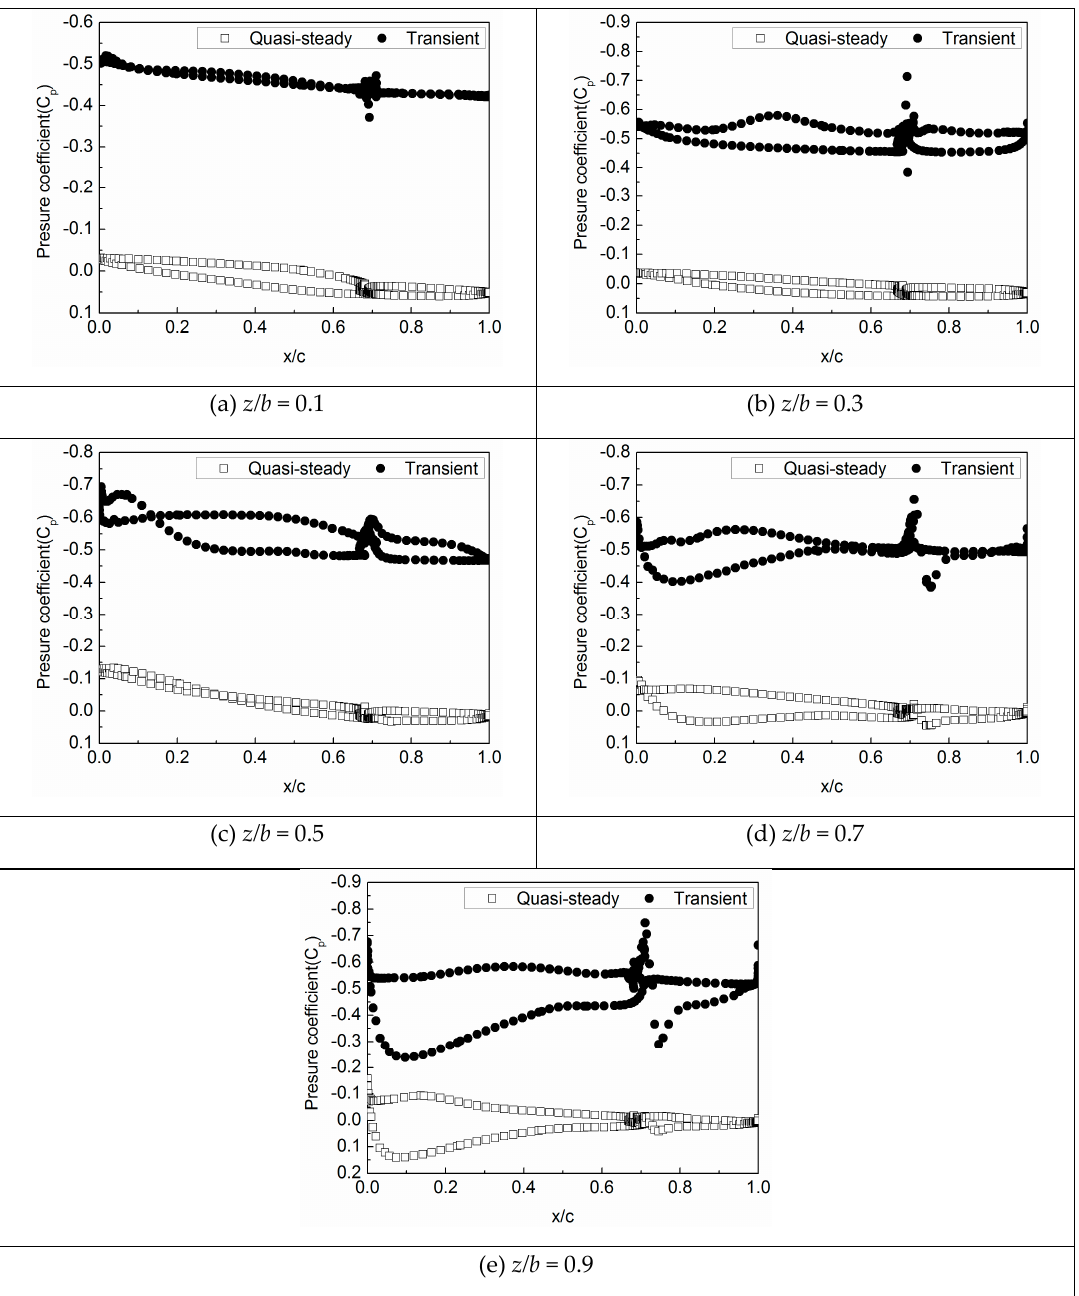
Figure 17. Pressure coefficient distributions at several spanwise positions on the wing at TA = 30 degrees. (a) z/b = 0.1; (b) z/b = 0.3; (c) z/b = 0.5; (d) z/b = 0.7;(e) z/b = 0.9